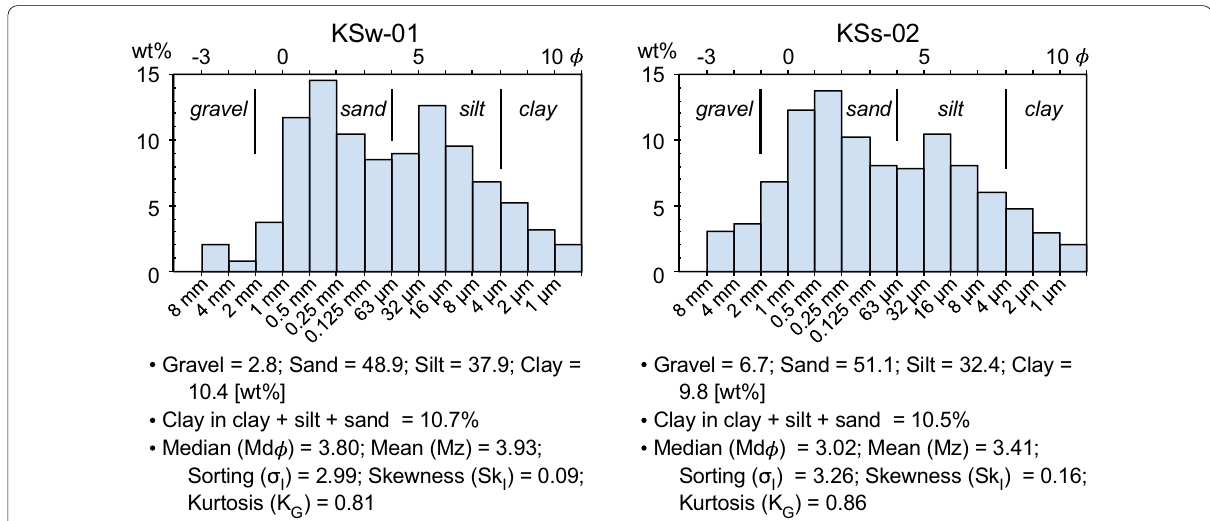
Fig. 6 Grain-size distribution of tephra samples. The KSw-01 sample was deposited on the window rim outside the no 29 cable car, and the KSs-02 covered the